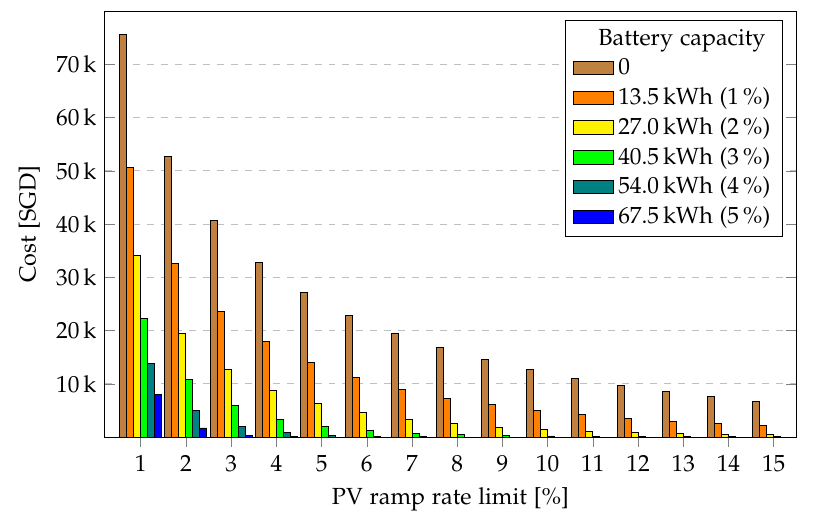
Figure 6. PV ramp cost over PV ramp rate limit for various battery capacities for one